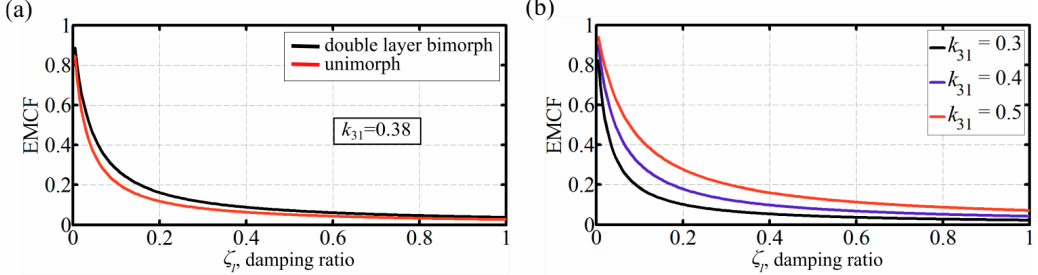
Figure 3. Double layer bimorph dynamic EMCF. ( a ) effect of damping ratio; k 31 = 0.38. The EMCF of an optimum thickness unimorph with steel passive layer is shown for reference. Practically, this unimorph configuration can achieve the best EMCF values; thus, the superiority of double layer bimorphs against unimorphs is demonstrated; ( b ) effect of the PZT layer transverse electromechanical coupling coefficient for double layer bimorphs.